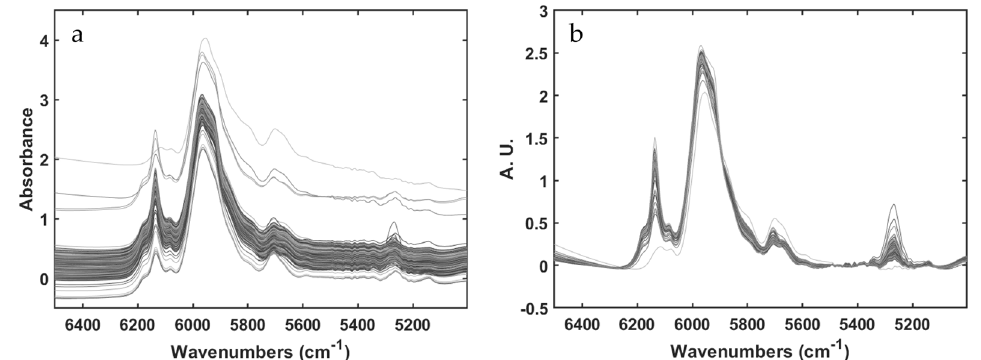
Figure 2. Spectra collected at NIR-RP-A, data block before ( a ) and after ( b ) baseline correction using automatic weighted least square method.